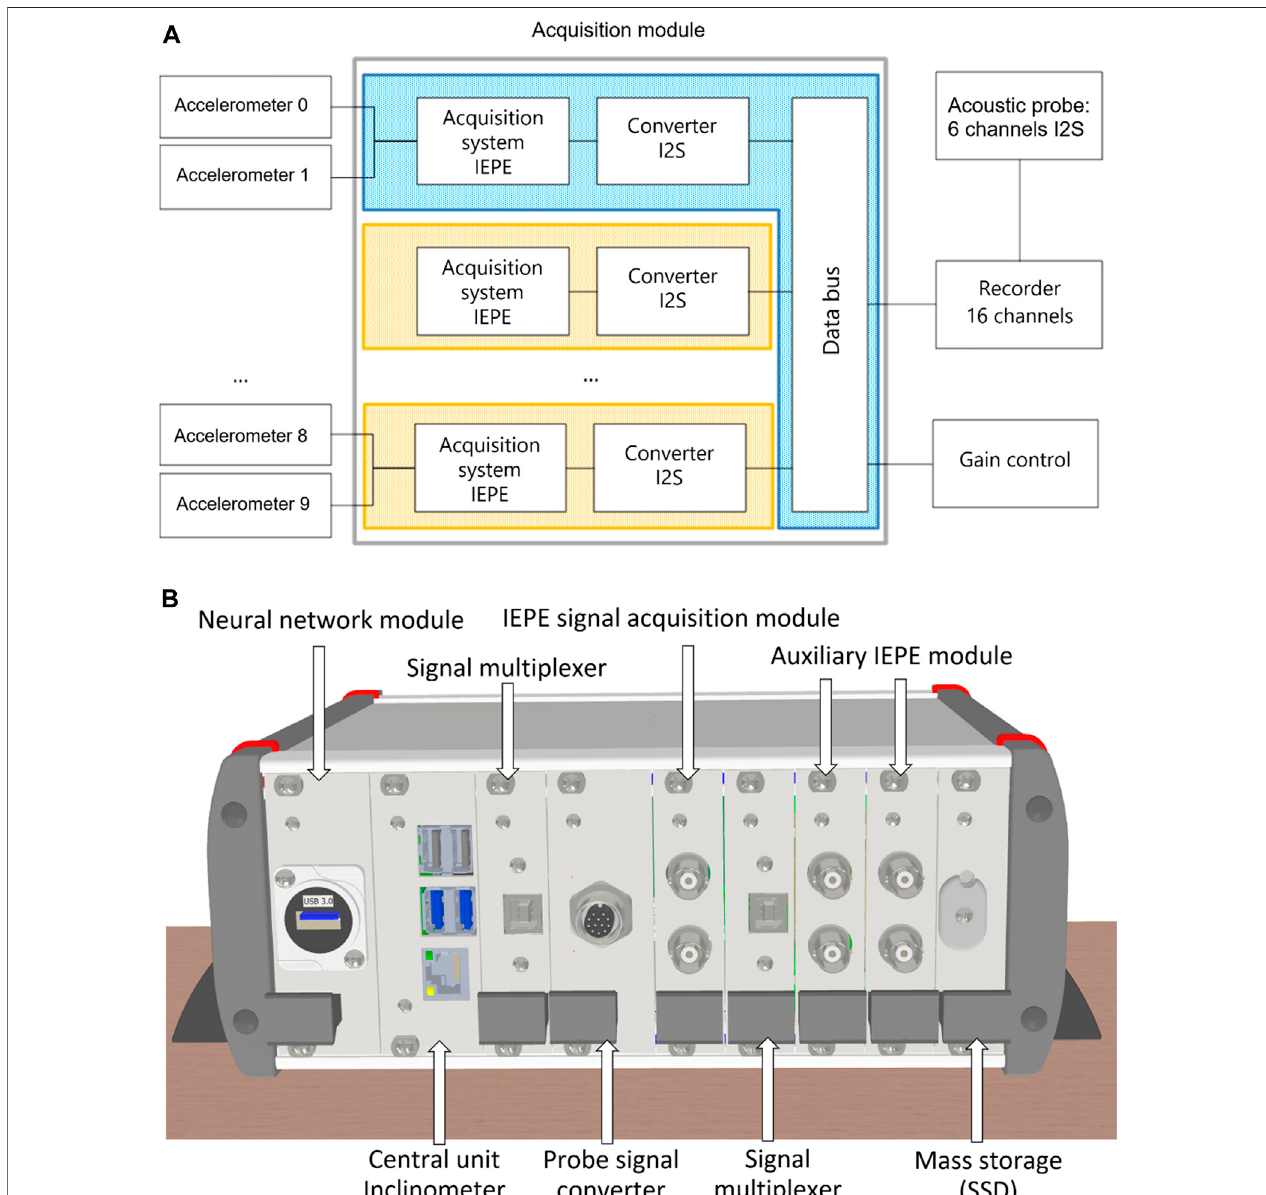
FIGURE 6 | Data acquisition module: (A) block diagram, (B) module design. Some elements of the developed device prototypes are patent pending [41].